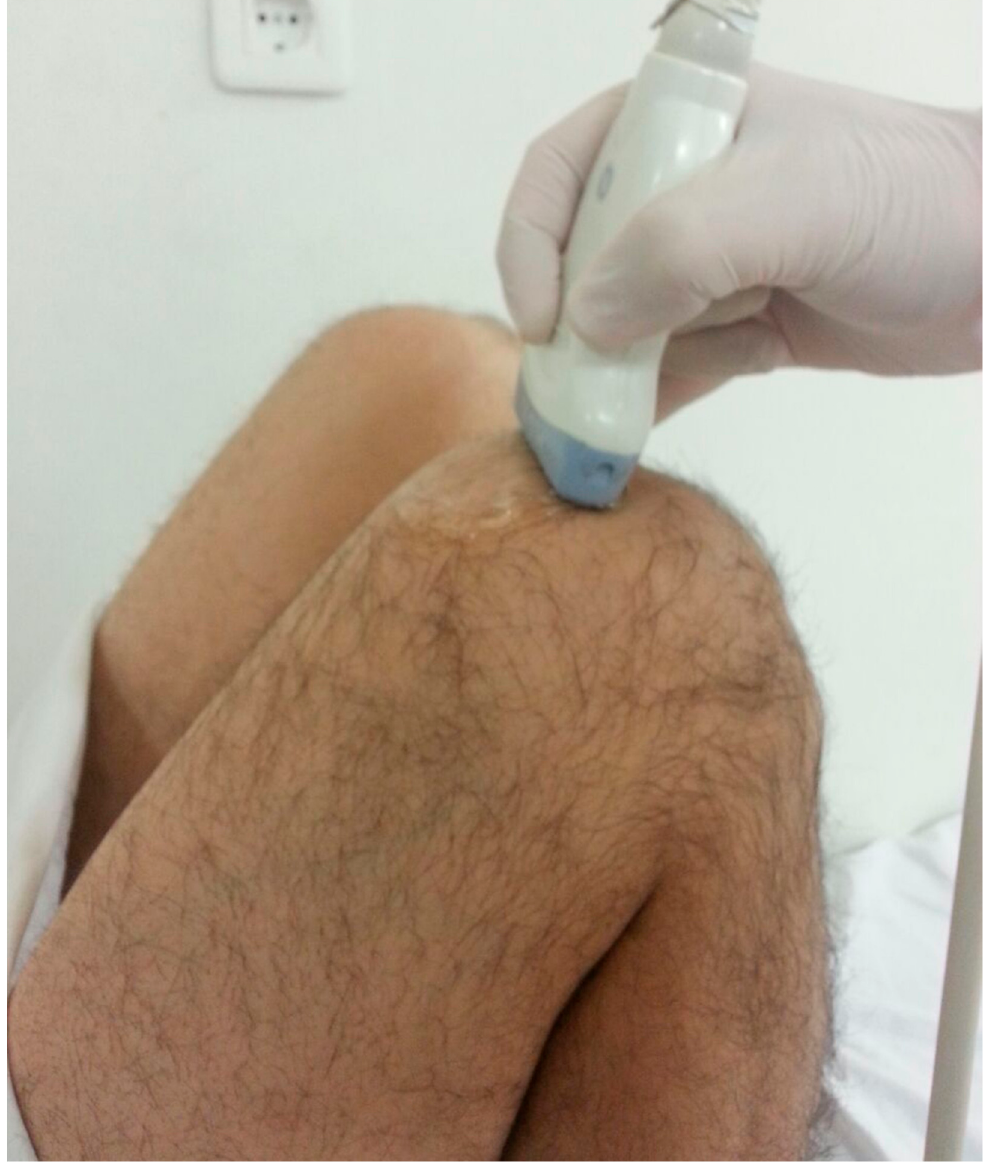
Figure 1. Experimental setup position of the knee and the ultrasound probe.